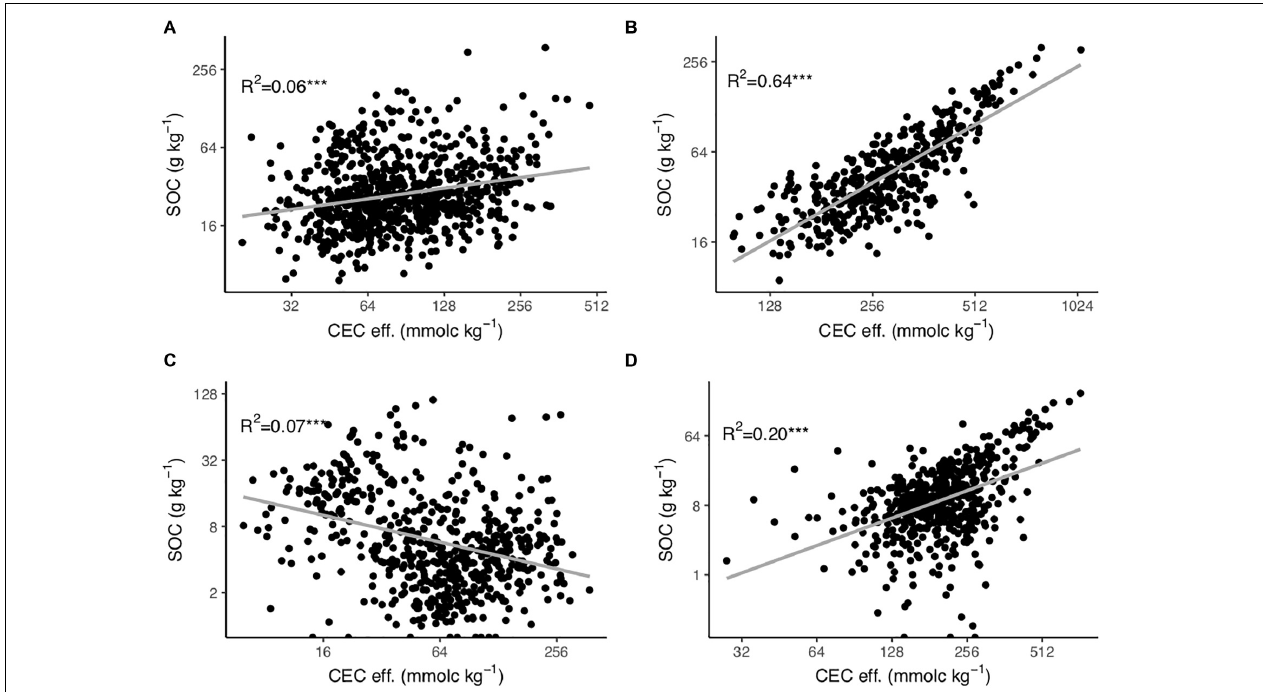
FIGURE 2 | Relationship between effective cation exchange capacity (CEC eff.) and soil organic carbon (SOC) content in (A) topsoils (0–30 cm depth) with soil pH < 5.5, (B) topsoils with soil pH > 5.5, (C) subsoils (30–120 cm depth) with soil pH < 5.5 and (D) subsoils with soil pH > 5.5. The axes are log-log scaled. *** p-value <